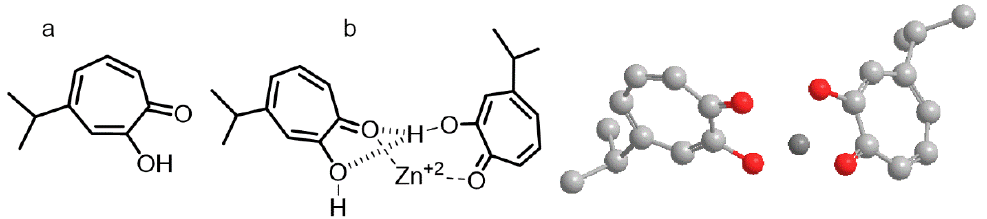
Figure 5. Structure ( a ) and three-dimensional study ( b ) of Hinokitiol (2-hydroxycyclohepta-2,4,6-trien-1-one). Light grey balls represent carbon atoms. Non linked dark grey balls represent zinc cations. Red balls represent oxygen atoms.